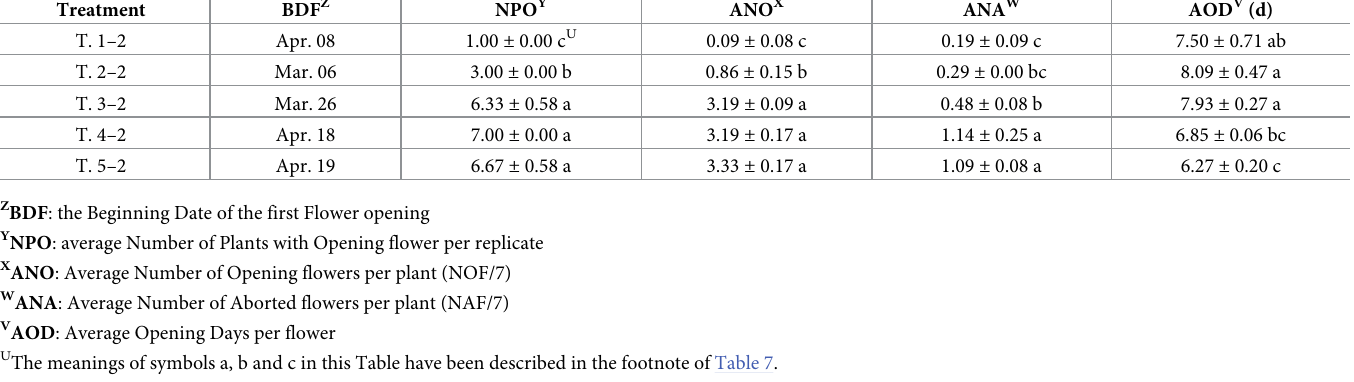
Table 8. Flowering performance of ‘Hang Baishao’ after transfer to a glasshouse with natural chilling and/or 5-azacytidine treatments. Treatment